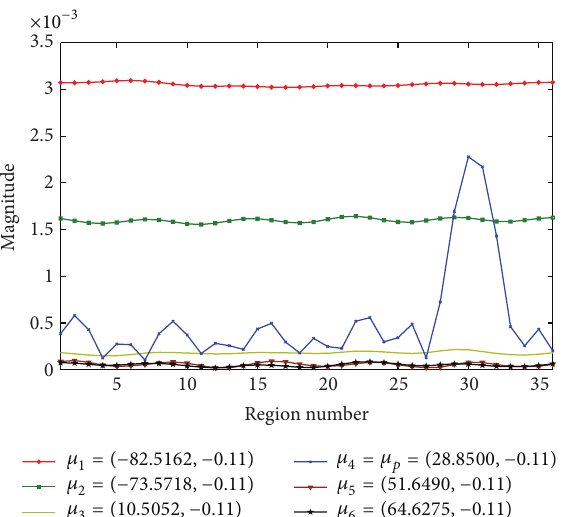
Figure 4: The magnitudes of 6 curves of b 𝛼 and SRR = − 15 dB.